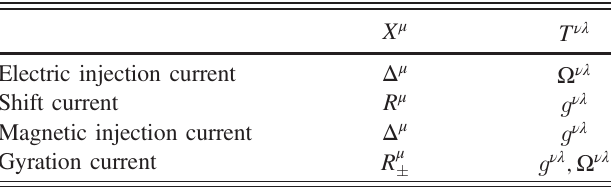
TABLE III. Director X μ and dipole-transition amplitude T νλ for the photocurrent responses allowed in insulators (see also Table I). are the group velocity difference, The directors Δ μ , R μ , and R μ (cid:4) shift vector, and chiral shift vector, respectively. The transition amplitude is characterized by the quantum metric g νλ and Berry curvature Ω νλ